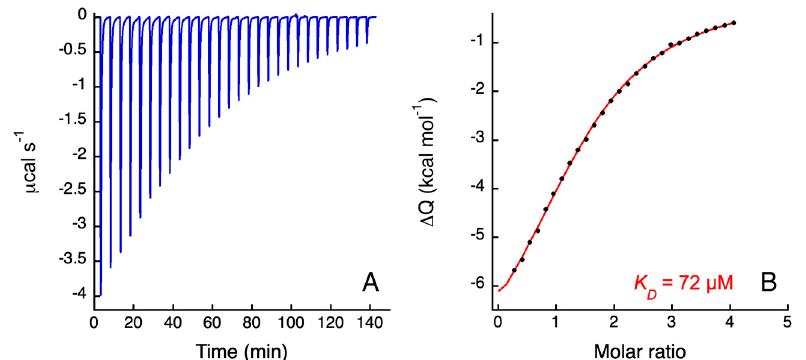
Figure 2. ITC titration data for the binding of NiSO 4 to h NDRG1*C. ( A ) Raw titration data represent the thermal effect of 27 × 10 µ L injections of Ni(II) onto or h NDRG1*C solution at pH 7.5. ( B ) Nor- malized heat of reaction data for the binding events of Ni(II) to h NDRG1*C were obtained integrating the raw data. The solid line represents the best fit of the integrated data, obtained by a nonlinear least-squares procedure, as described in the text. The calculated dissociation constant is indicated.